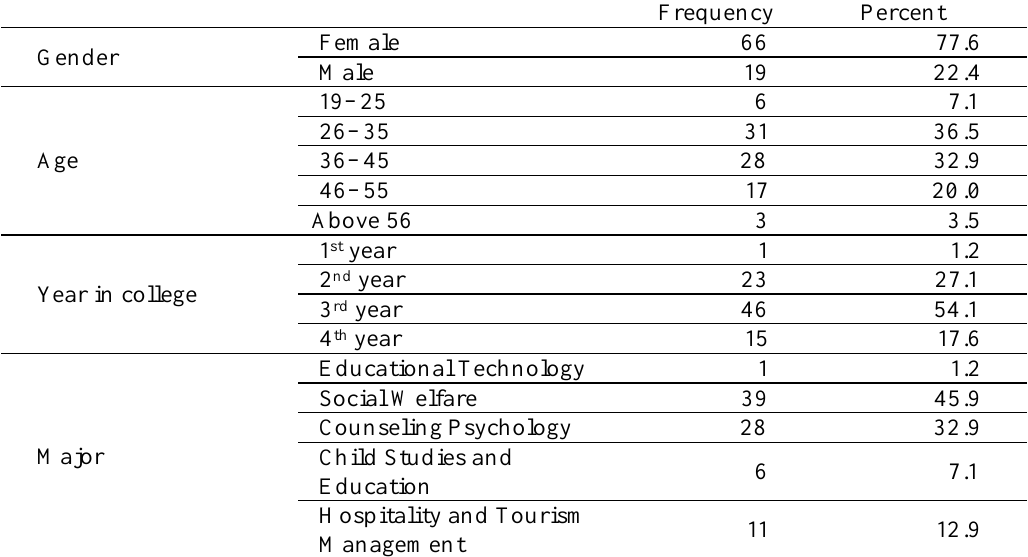
Participants’ Background